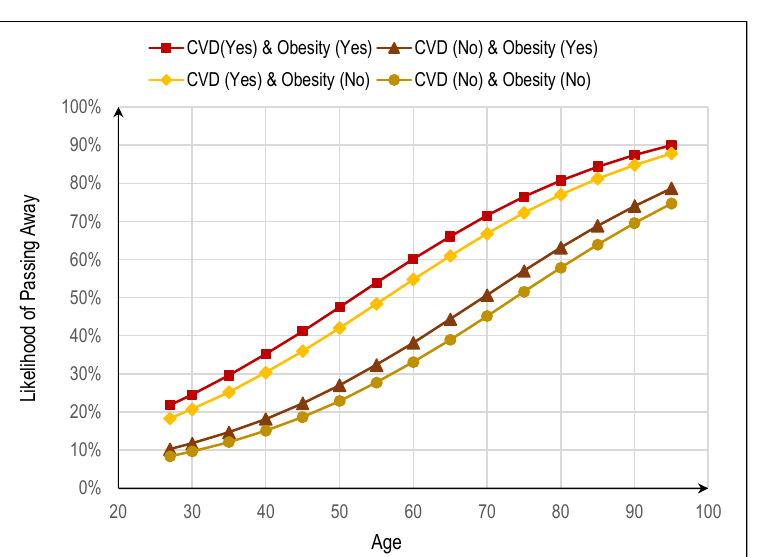
and CVD , with the models being statistically significant at 0.10 level.